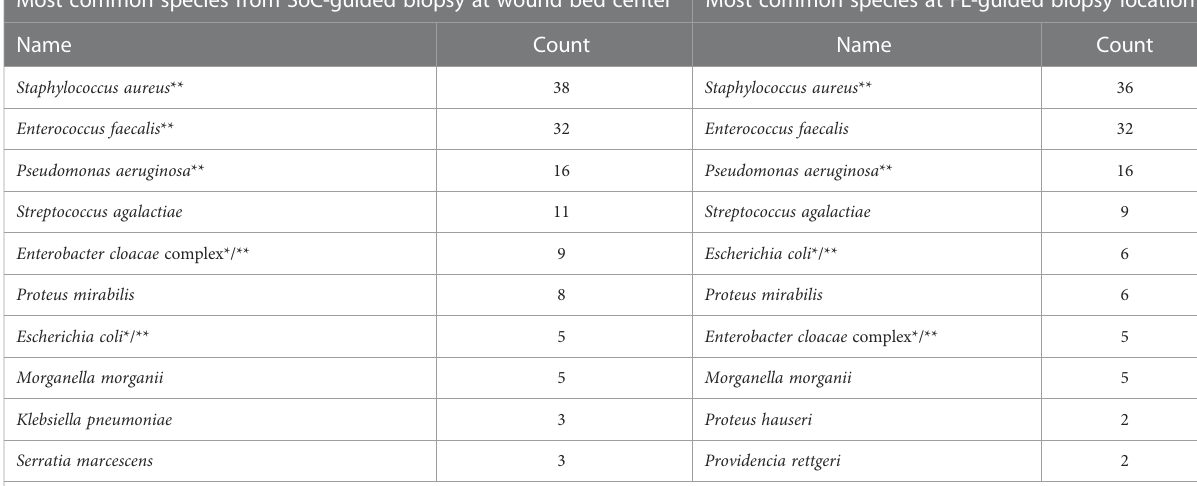
TABLE 3 Top 10 species identi fi ed in each sampling location. Most common species from SoC-guided biopsy at wound bed